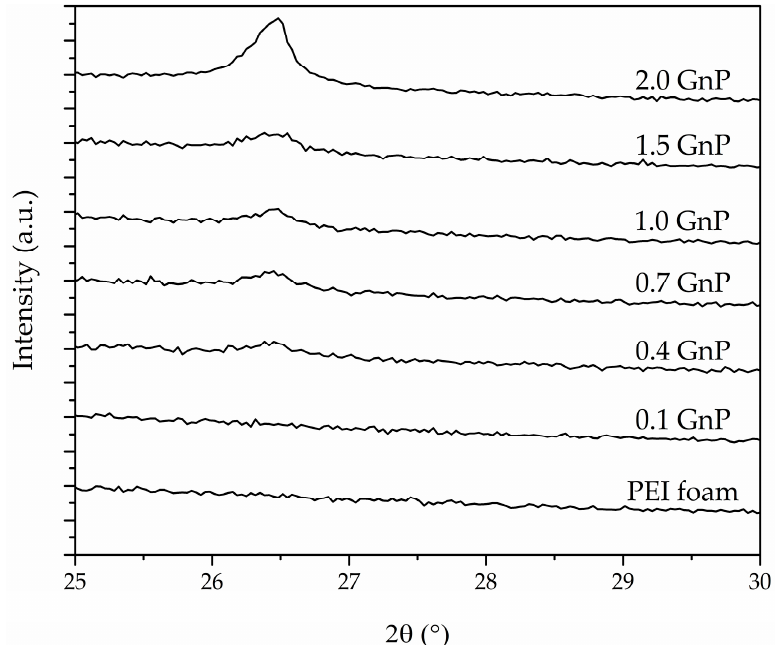
Figure 4. X-ray spectra of PEI and PEI-GnP nanocomposite foams illustrating the disappearance or reduction in intensity of GnP’s (002) characteristic diffraction plane.